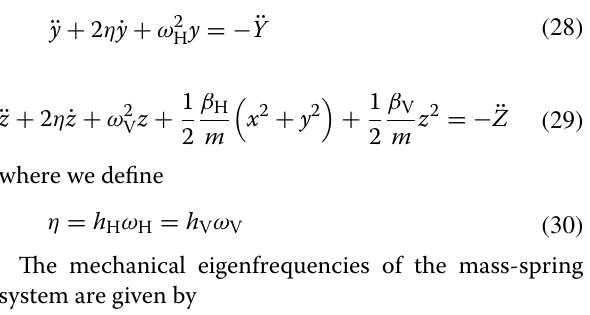
for the horizontal and vertical directions, respectively.